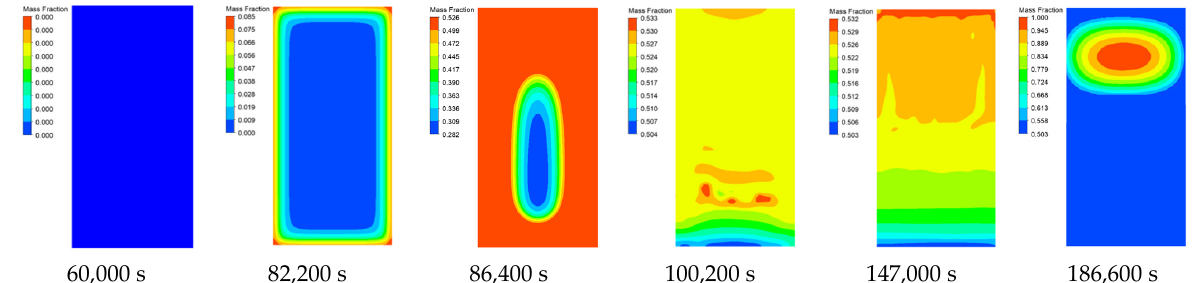
Figure 7. Liquid phase cloud image of 50% spherical NQ/50% DNAN at different times.